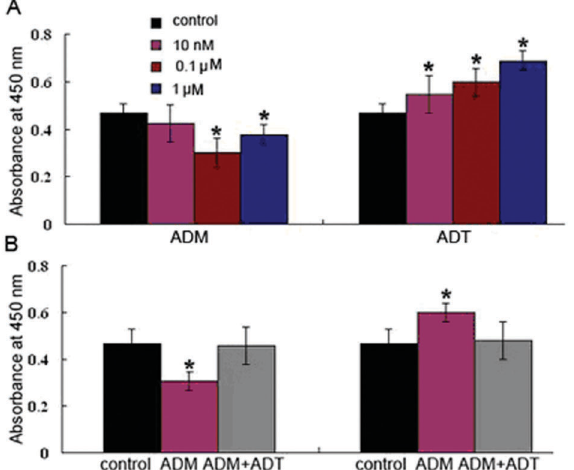
Figure 2. A , Effect of increasing concentrations of ADM or ADT on cell proliferation in cultured PASMCs. Cell proliferation was assayed with BrdU incorporation. Data are reported as mean±SE absorbance for n=6 rats per group. *P , 0.05 vs control (one-way ANOVA). B , Effect of 0.1 m M ADM, ADT, or ADM++ADT on the cell proliferation of cultured rat PASMCs.